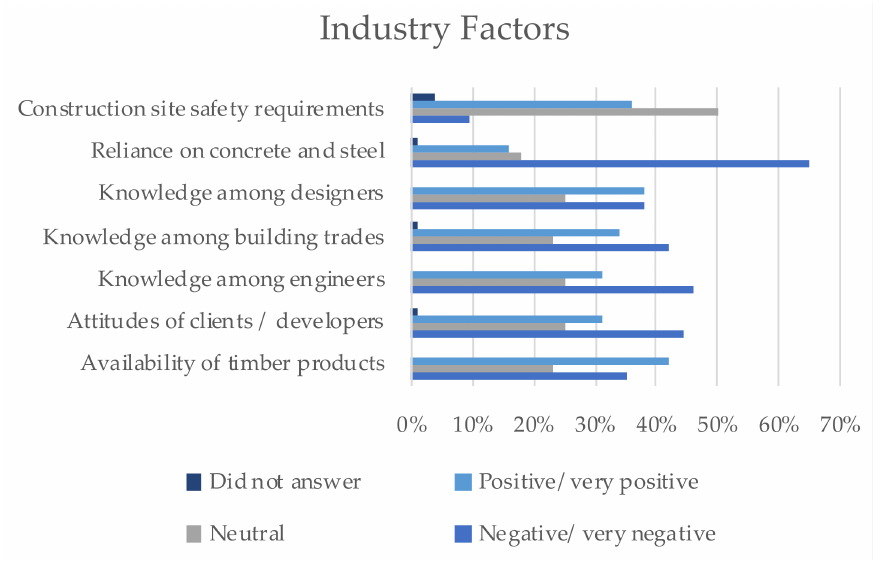
Figure 11. Responses to the question, ‘What impact do the following building industry factors have on the adoption of timber in multi-storey projects in Australia?’ [very negative, negative, neutral, positive or very